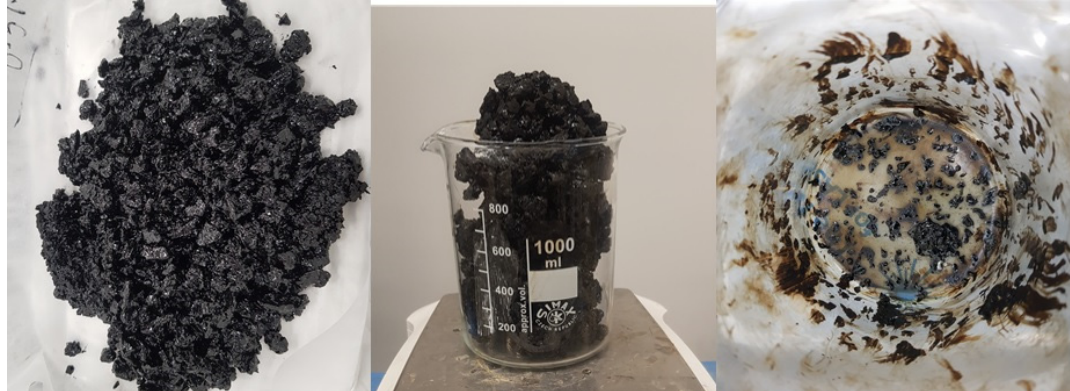
Figure16. Binderdraino ff process. AsphaltmixpreparedwithCBsmodifiedbitumen( left ); preparation of binder drain o ff test ( middle ); drained o ff binder with fine aggregates retained at the bottom of glass flask ( right